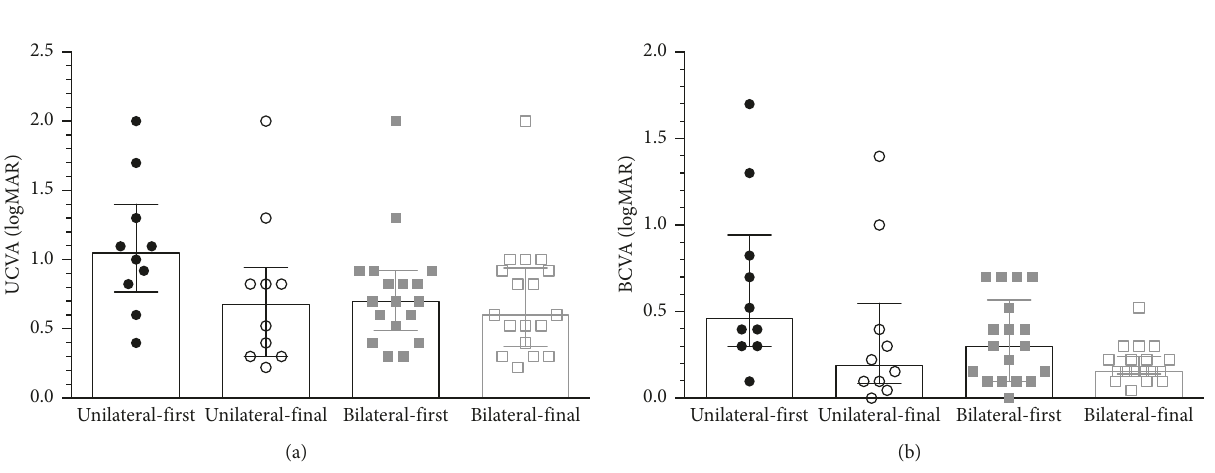
Figure 3: Comparison of visual acuity ((a) UCVA and (b) BCVA) between children with unilateral pathological myopia and bilateral myopia at their first and final visits. UCVA: uncorrected visual acuity; BCVA: best-corrected visual acuity; logMAR: Logarithm of the Minimum Angle of